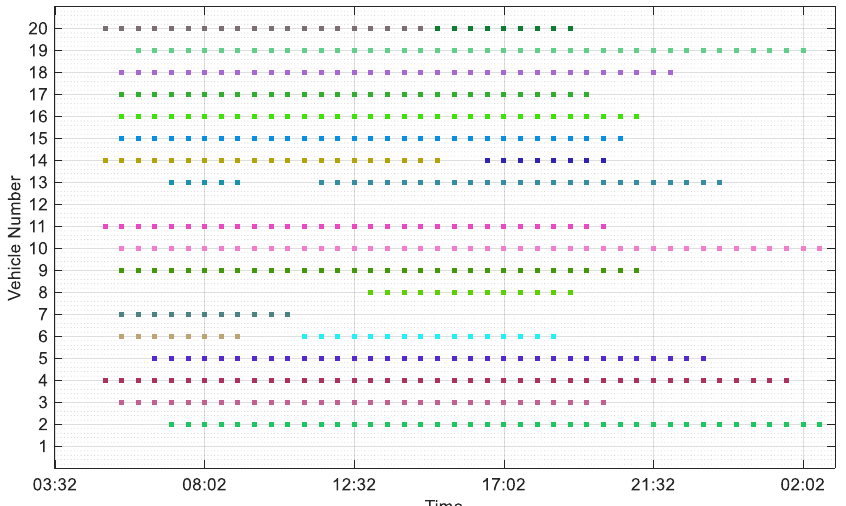
Figure 3. Fleet management for a selection of vehicles on one representative day as determined by an exemplary optimi- zation process. Each trip has a distinctive color. The colored trips are assigned to the vehicle numbers 1 to